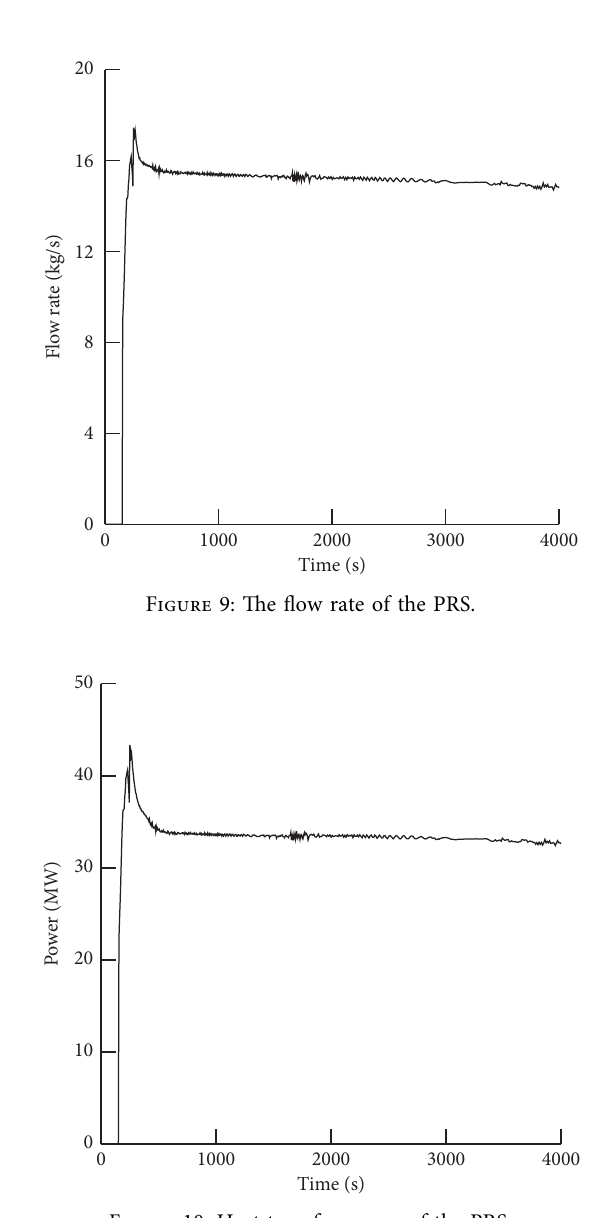
Figure 8: The pressure of the pressurizer.